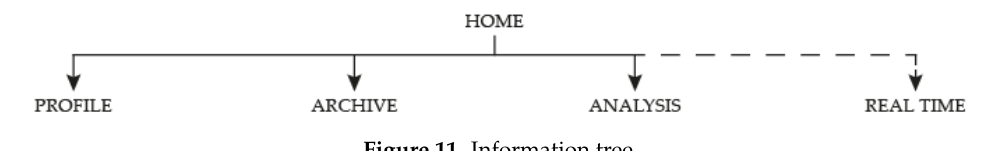
Figure 10. Sensors.